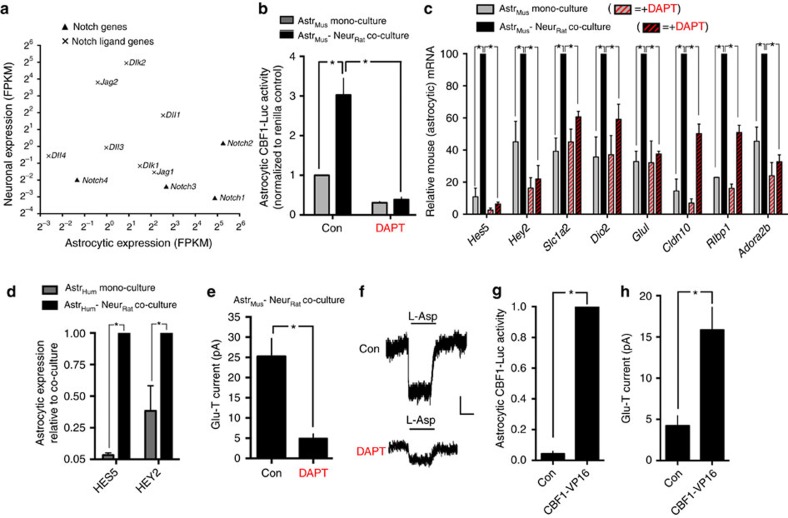
Notch signalling contributes to neuron-induced astrocytic gene expression and functional maturation.(a) Mean expression levels (n=3) of Notch and Notch ligand genes are compared between pure mouse astrocyte cultures and pure mouse neuronal cultures, derived from RNA-seq data and calculated as FPKM. (b) Neurons induce astrocytic Notch/CBF1-dependent gene expression. Mouse astrocytes were transfected with a CBF1-luciferase reporter (plus renilla control) before rat neurons were overlaid (or not) for 9 days in the presence or absence of the γ-secretase inhibitor DAPT (10 μM, Tocris). Firefly luciferase activity was normalized to Renilla transfection control. *P<0.05 (two-way analysis of variance (ANOVA) plus Sidak’s post hoc test (n=3)). (c) Mouse astrocyte mono-cultures and mouse astrocyte/rat-neuron co-cultures were treated with DAPT, and gene expression analysed at DIV9, normalized to housekeeping gene H1f0, using mouse species-specific PCR primers. *P<0.05 (two-way ANOVA, plus Holm-Sidak's multiple comparisons test, n=3). (d) Neuron-induced expression of Notch target genes analysed in human primary astrocytes. *P<0.05 (unpaired t-test, n=5). (e,f) DAPT treatment inhibits the neuron-induced increase in glutamate transporter capacity in astrocytes in response to 200 μM L-Aspartate. *P<0.05 (unpaired t-test, n=22 Con, n=8 DAPT). (f) Example traces. Scale bar, 5 s, 10 pA. (g) Verification that CBF1-VP16 induces Notch/CBF1-dependent gene expression, compared to control plasmid (β-globin). Neuron-free astrocyte mono-cultures were used for this experiment. *P<0.05 (t-test). (h) CBF1-dependent gene expression is sufficient to induce glutamate transporter currents in astrocytes. Astrocyte mono-cultures were transfected as indicated (plus eGFP marker) and glutamate transporter currents in response to 200 μM L-Aspartate application measured 9 days later. *P<0.05 (unpaired t-test, n=8 Con, n=10 CBF1-VP16). All error bars represent s.e.m.